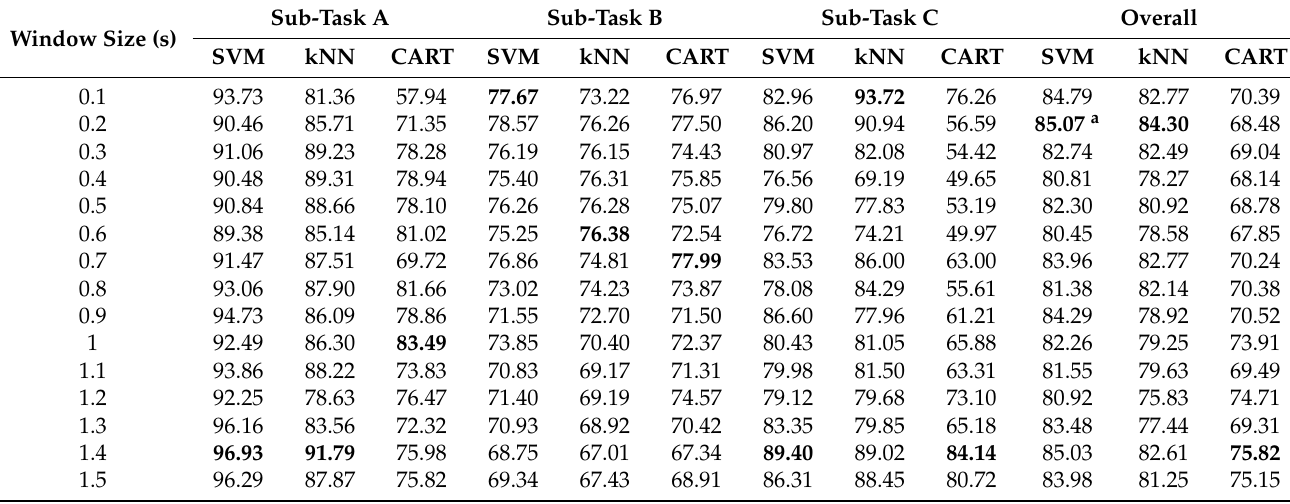
Table 6. The precision of the sub-task segmentation using machine learning approaches (%) vs. different window sizes (s). Window Size